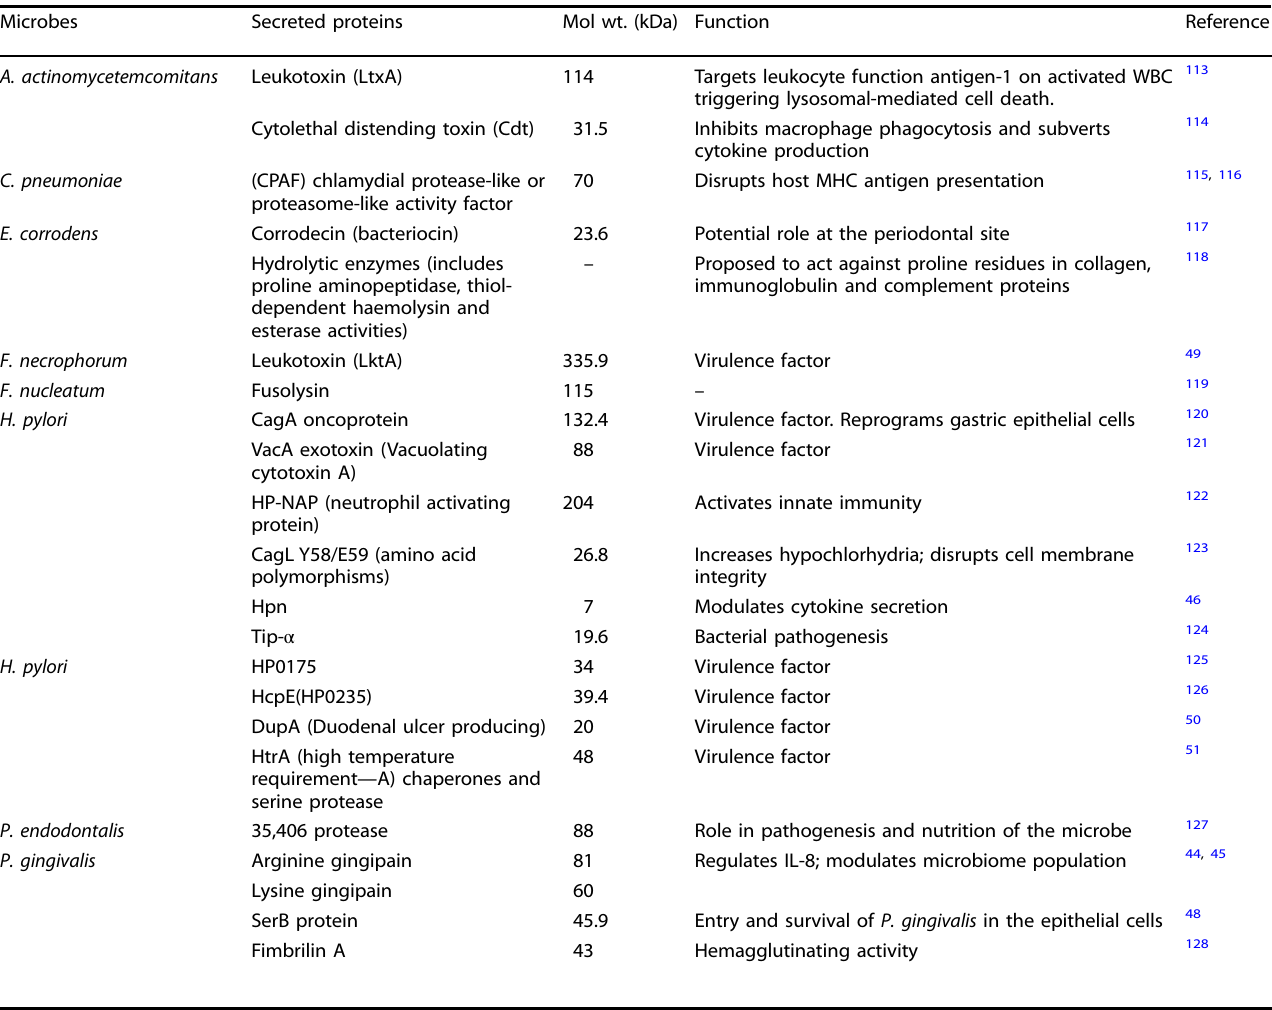
Table 2. Proteins and peptides secreted by atherosclerotic plaque-associated bacteria and their potential roles in disease aetiology